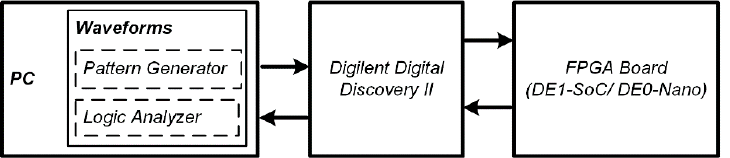
Figure 8. Data acquisition technique.